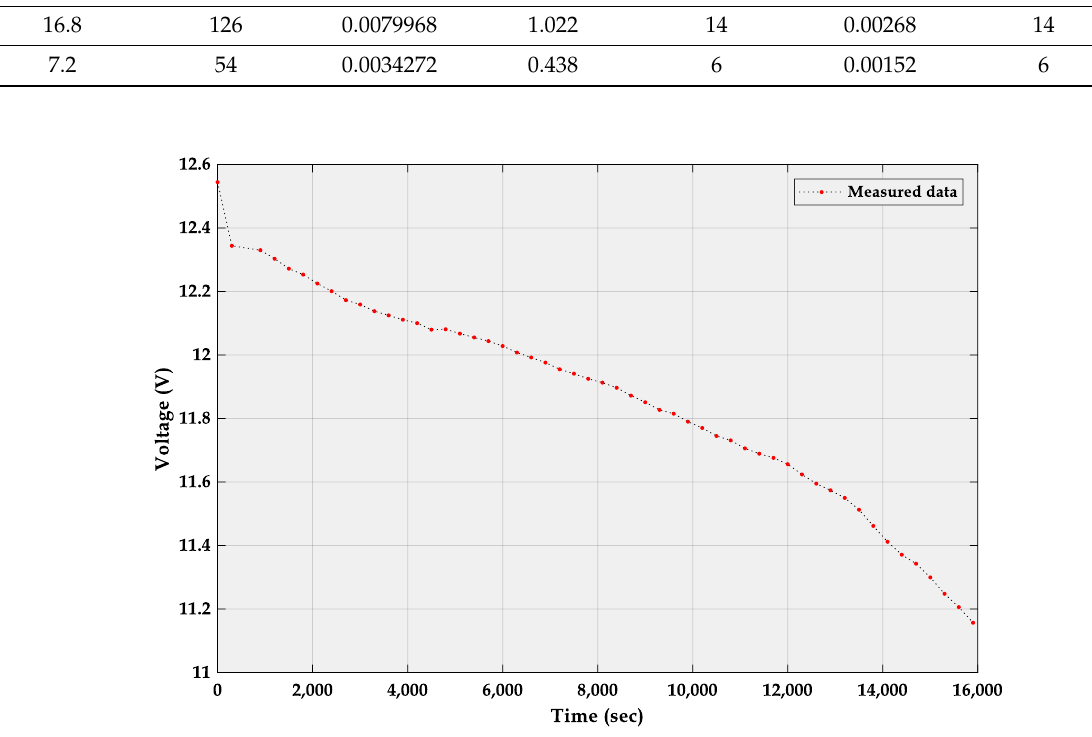
Figure 9. Experimental voltage curves of Banner 75 Ah.